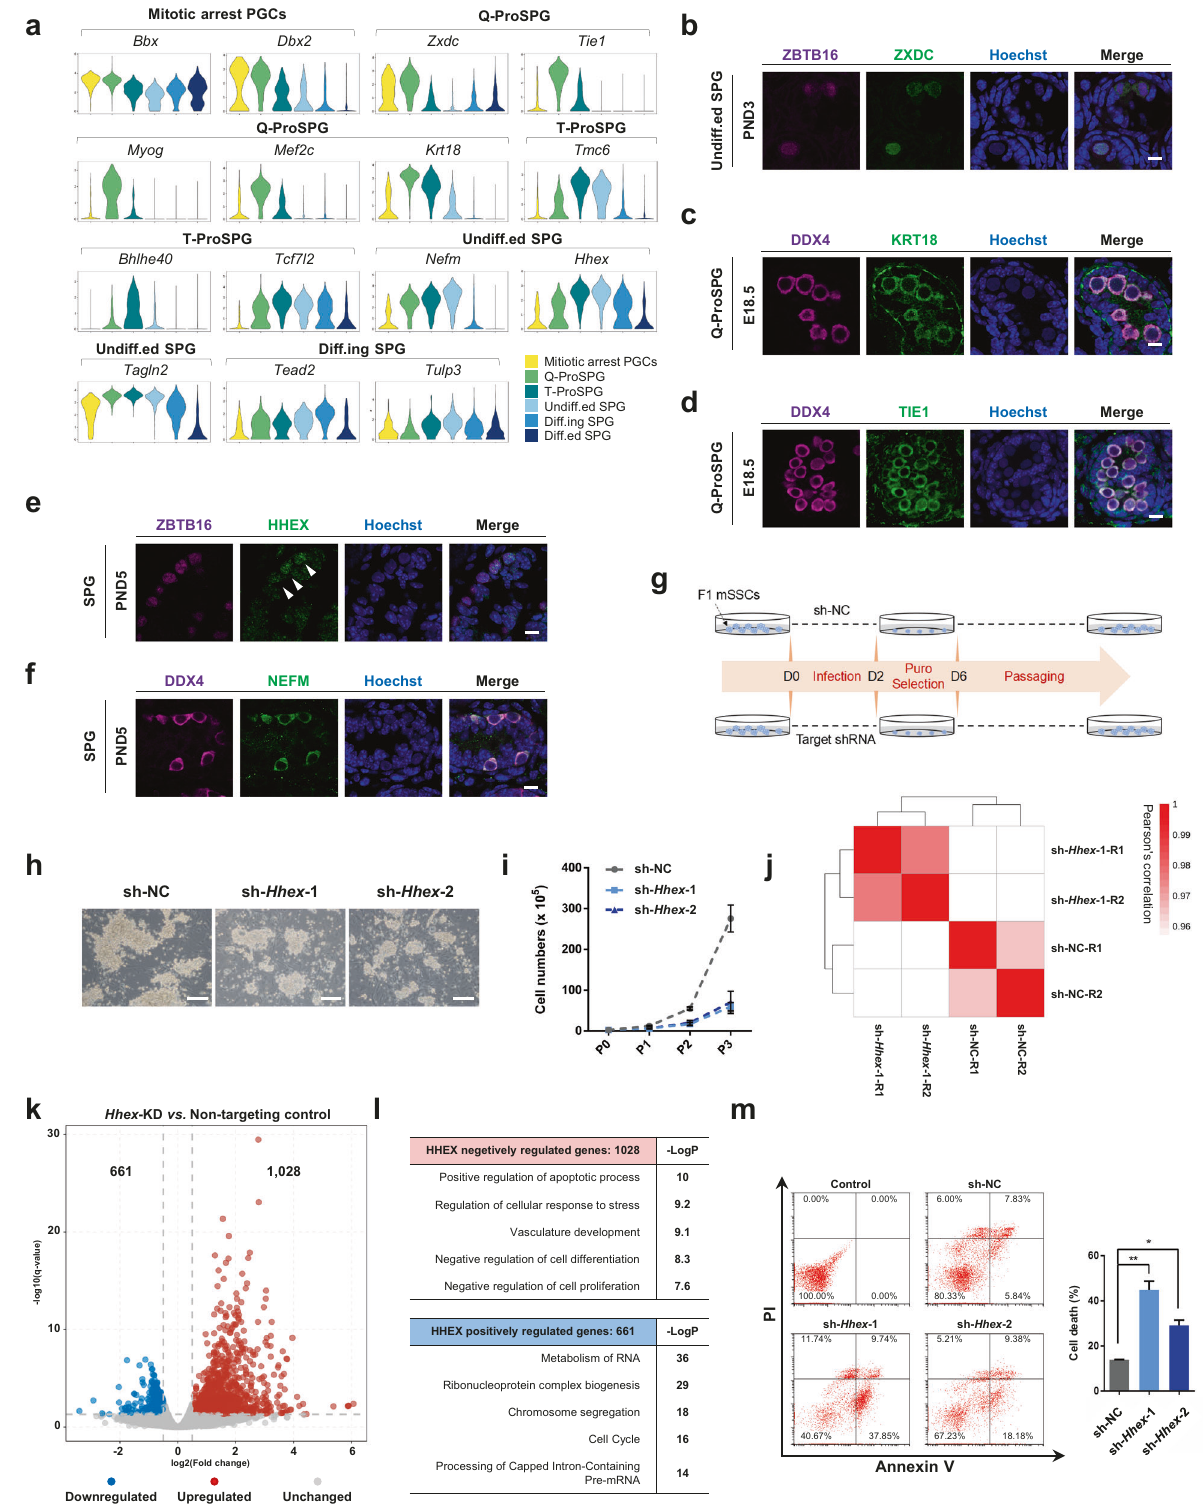
661 downregulated genes (Fig. 6k, Supplementary Data 5). GO regulation of cell differentiation ” , as well as “ Negative regulation analysis revealed that HHEX positively regulated genes were of cell proliferation ” , consistent with the previous studies 73 – 75 . In support of these fi ndings, knockdown of Hhex promoted the cell associated with “ Metabolism of RNA ” , “ Chromosome segrega- death of mSSCs (Fig. 6m). Meanwhile, we found a clear cell-cycle tion ” , “ Cell cycle ” , “ DNA replication ” , “ Mitotic G1 phase, and arrest of mSSCs induced by Hhex knockdown (Supplementary G1/S transition ” (Fig. 6l, Supplementary Data 5). While HHEX Fig. 10i), along with a dramatic downregulation of cyclin genes negatively regulated genes were enriched in terms such as “ Positive regulation of apoptotic process ” and “ Negative ( Ccna2 , Ccnb1 , and Ccnb3 ) and cyclin-dependent-kinase genes NATURE COMMUNICATIONS| (2021) 12:6839